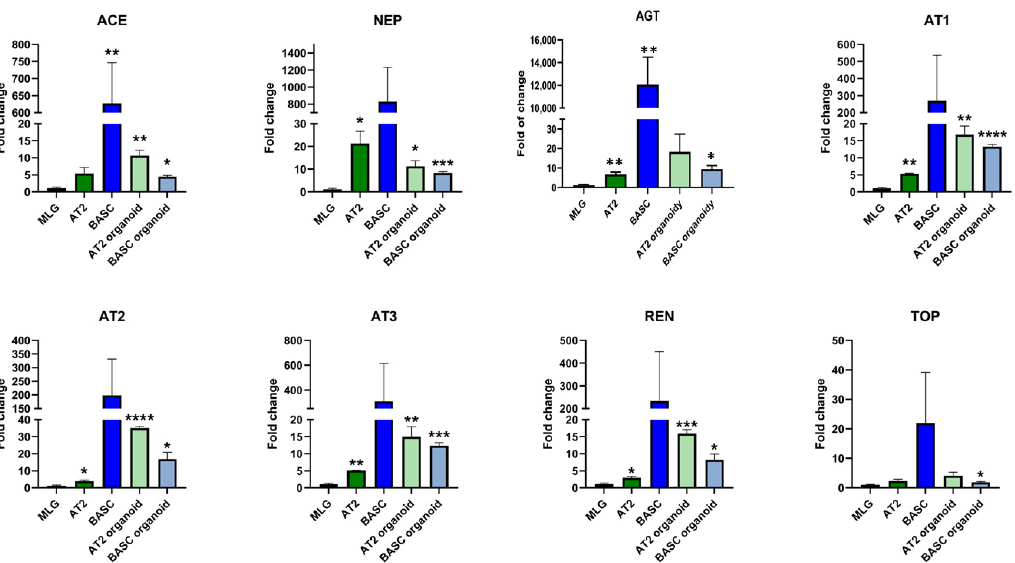
Figure 2. Relative mRNA expression of the genes involved in RAA system. Lung fibroblast cell line (MLG) was used as reference point for all examined genes expression. In order to analyze relative expression, comparative Δ CT method was employed. This method is a convenient way to calculate relative gene expression levels between different samples in that it directly uses the threshold cycles generated by the qRT-PCR system for calculation. * p < 0.05, ** p < 0.01, *** p < 0.001, **** p < 0.0001.